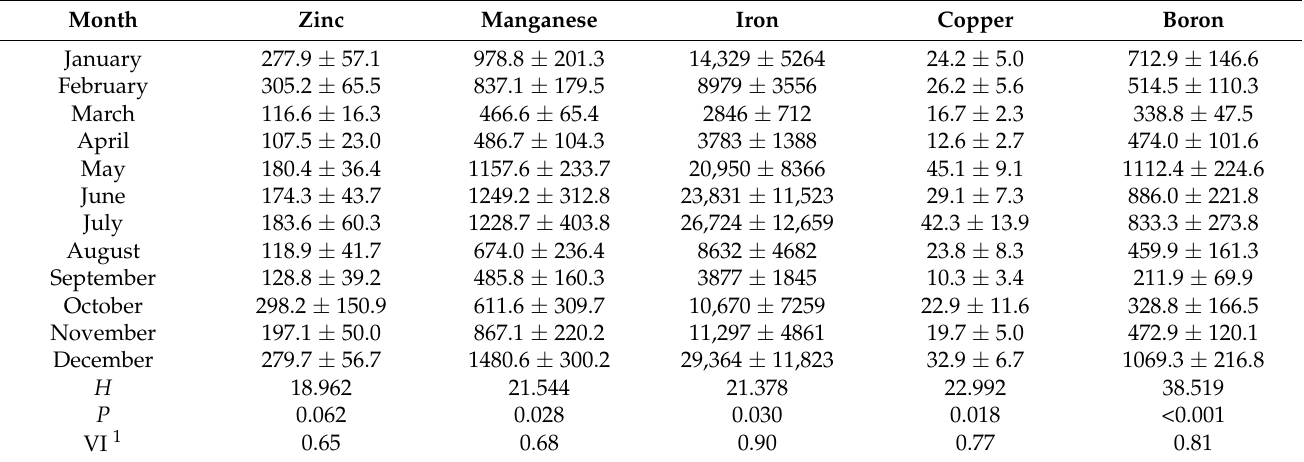
Table 2. The influence of month of year on micronutrient return ( µ g · m − 2 ) in Serianthes nelsonii leaf litter.